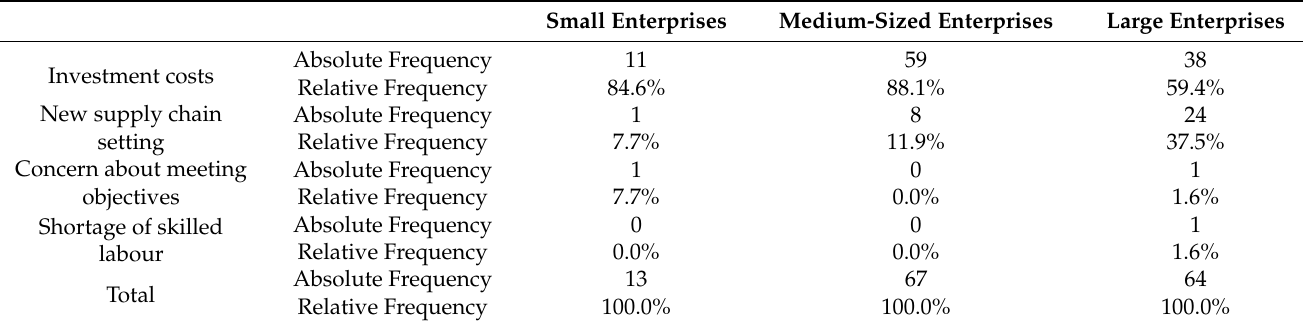
Table 6. Data file structure by